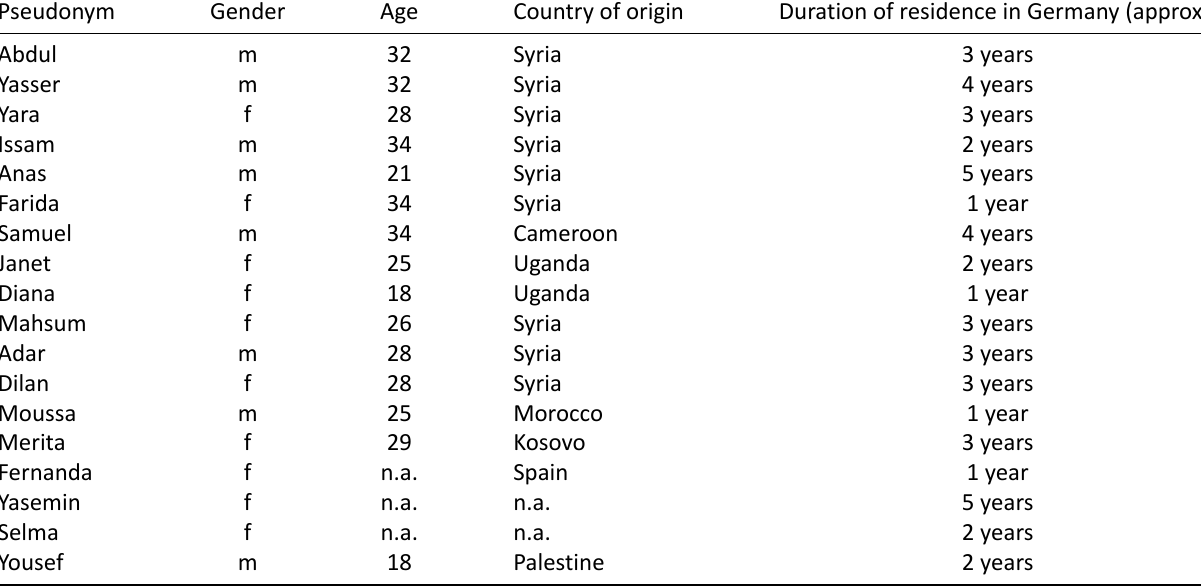
Table 1. Characteristics of the